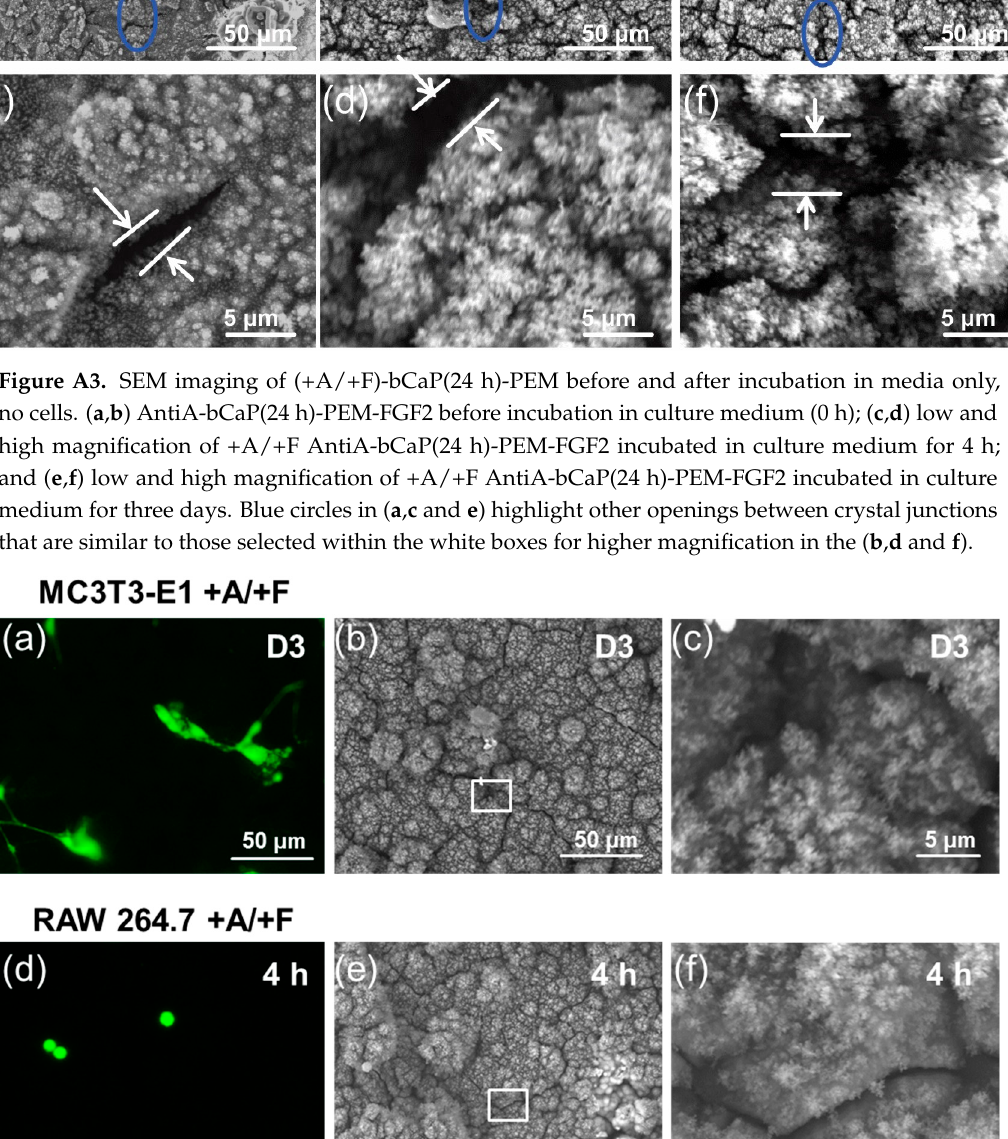
Figure A4. SEM imaging of (+A/+F)-bCaP(24 h)-PEM) with either MC3T3-E1 or RAW 264.7 cells: ( a ) day three LIVE ® staining of MC3T3-E1 on +A/+F AntiA-bCaP(24 h)-PEM-FGF2; ( b , c ) low and high magnification SEM of AntiA-bCaP(24 h)-PEM-FGF2 after three days of MC3T3-E1 culture; white square in ( b ) shows area of higher magnification in ( c ); ( d ) 4 h LIVE ® staining of RAW 264.7 cells on AntiA-bCaP(24 h)-PEM-FGF2; and ( e , f ) AntiA-bCaP(24 h)-FGF2 after 4 h of RAW 264.7 culture. White square in ( e ) shows area of higher magnification shown in ( f